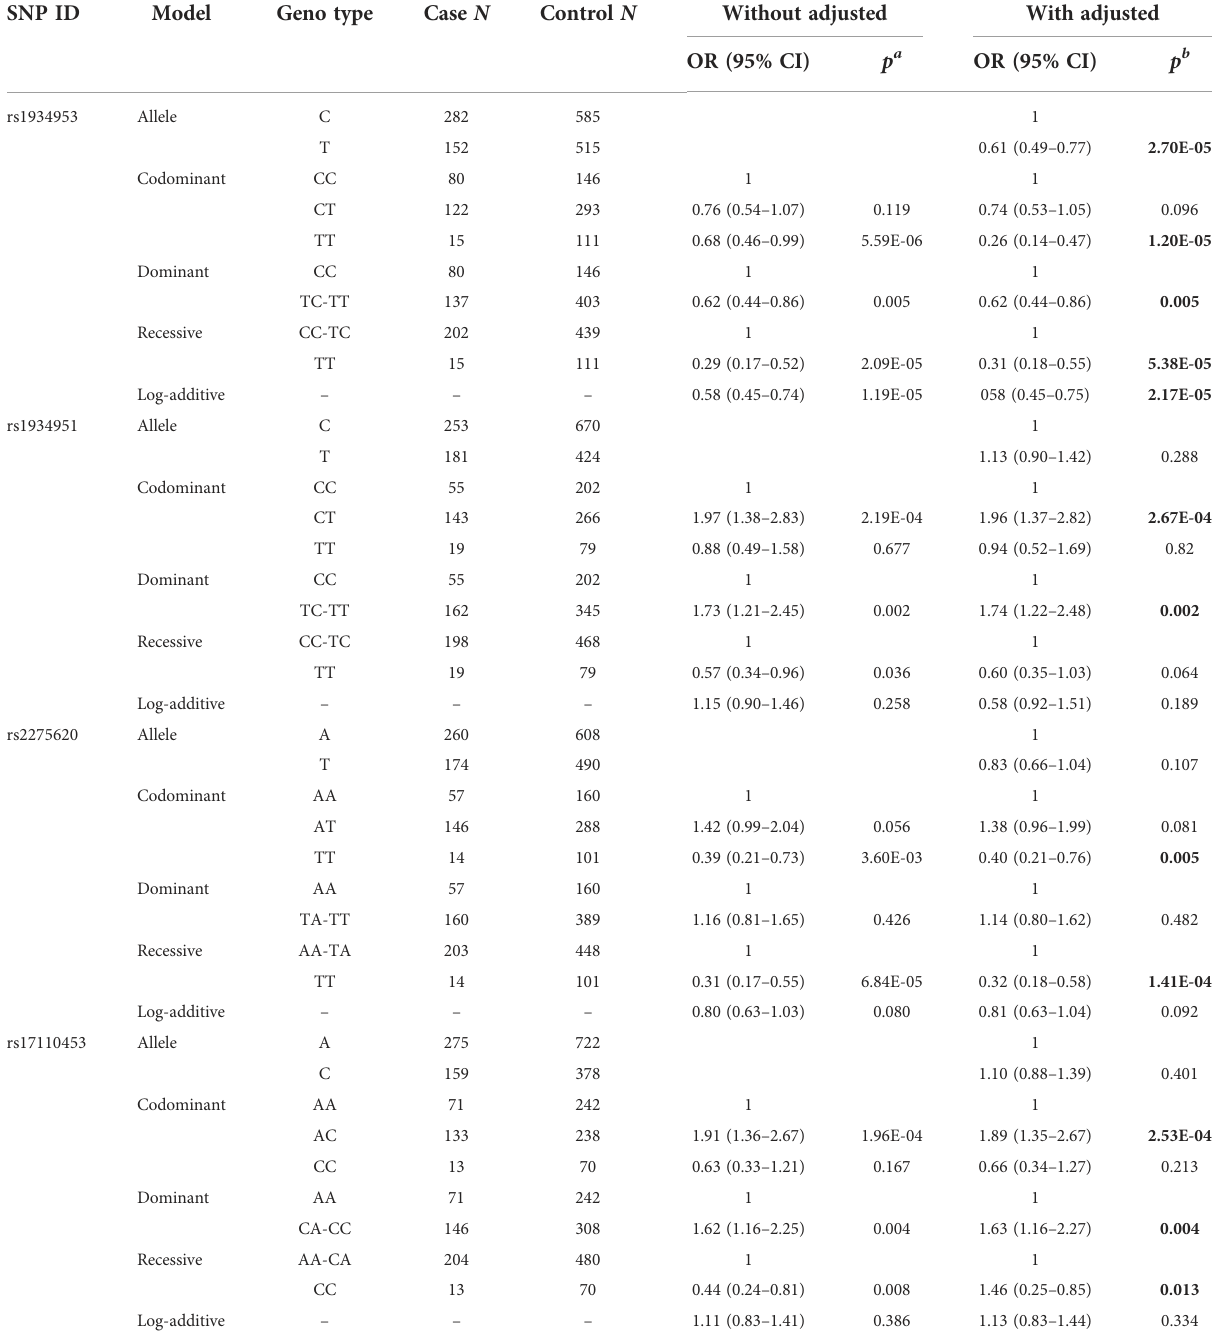
TABLE 4 Association analysis between CYP2C8 SNPs and bladder cancer